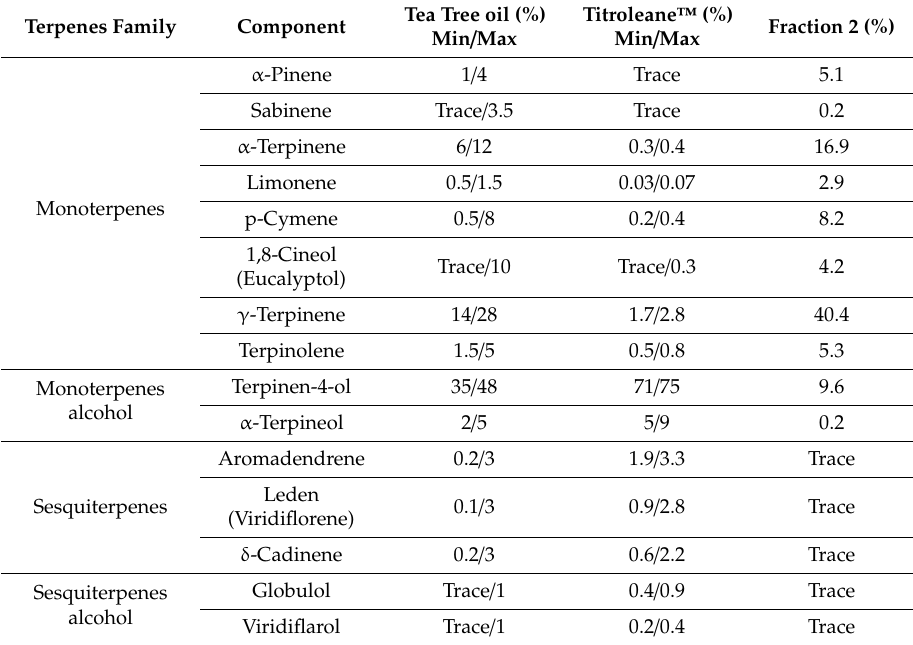
Table 1. Chromatographic profile of Tea Tree oil, Titroleane ™ , and Fraction